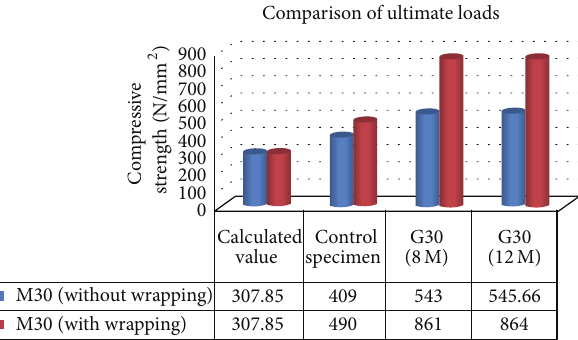
Figure 3: Comparisons of ultimate loads.